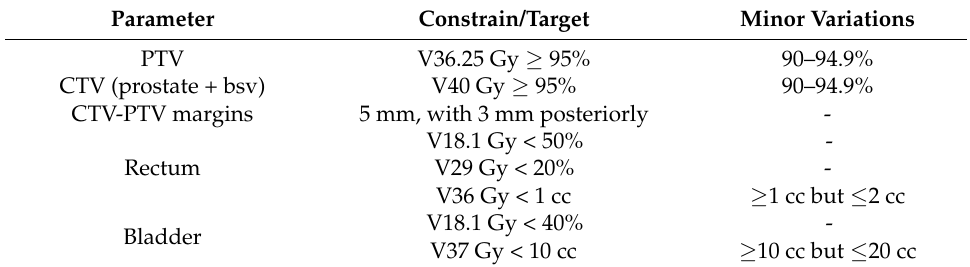
Table 1. Prostate SBRT dose constraints and planning objectives (derived from PACE phase III